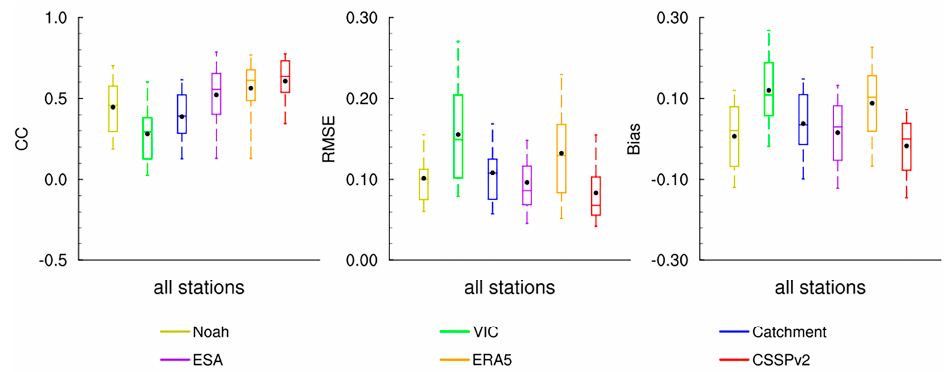
Figure 2. Correlation coefficient (CC), root mean square error (RMSE), and bias of different models and satellite data evaluated at all stations. The box graph shows the 95% quantile, 75% quantile, median, 25% quantile, and 5% quantile from top to bottom. The black dot is the average value.